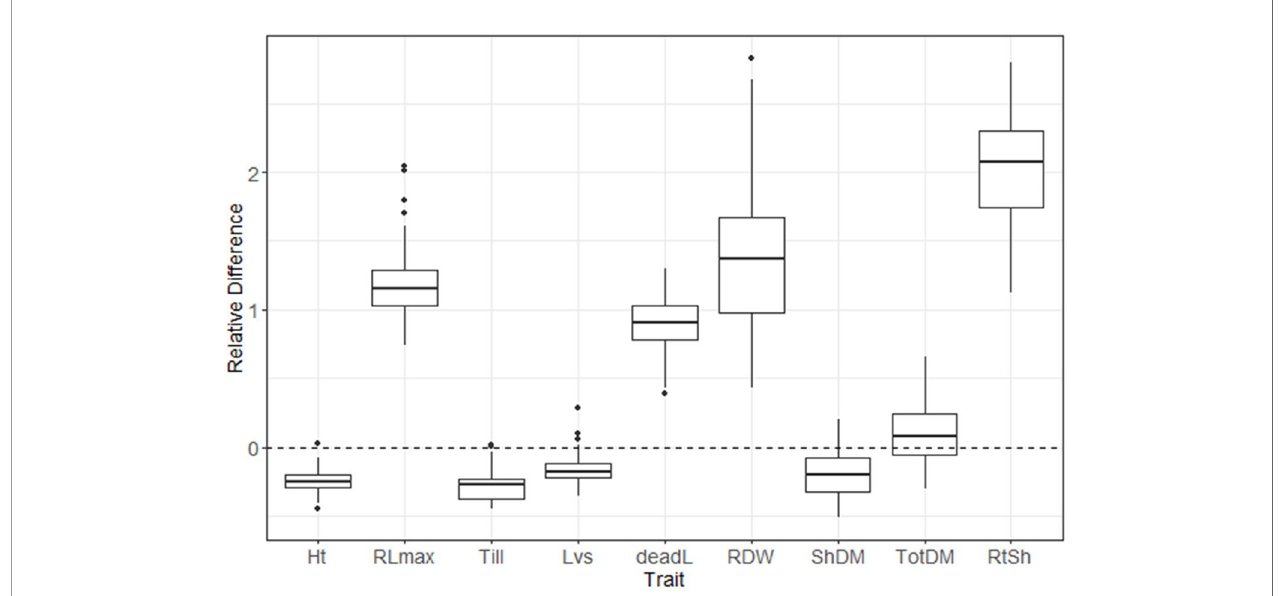
FIGURE 2 | Distribution of relative difference ([low S - high S]/high S) values from evaluated phenotypic parameters. Thick lines inside the box represent the median of the distribution, while the lower and upper boundaries represent the fi rst and third quartile, respectively. Relative difference was calculated as: (low-S minus high- S)/high-S. Ht, plant height; RLmax, maximum root length; Till, number of tillers; Lvs, number of leaves; deadL, number of dead leaves; RDM, root dry matter; ShDM, shoot dry matter; totDM, total dry matter; RtSh, root:shoot ratio.